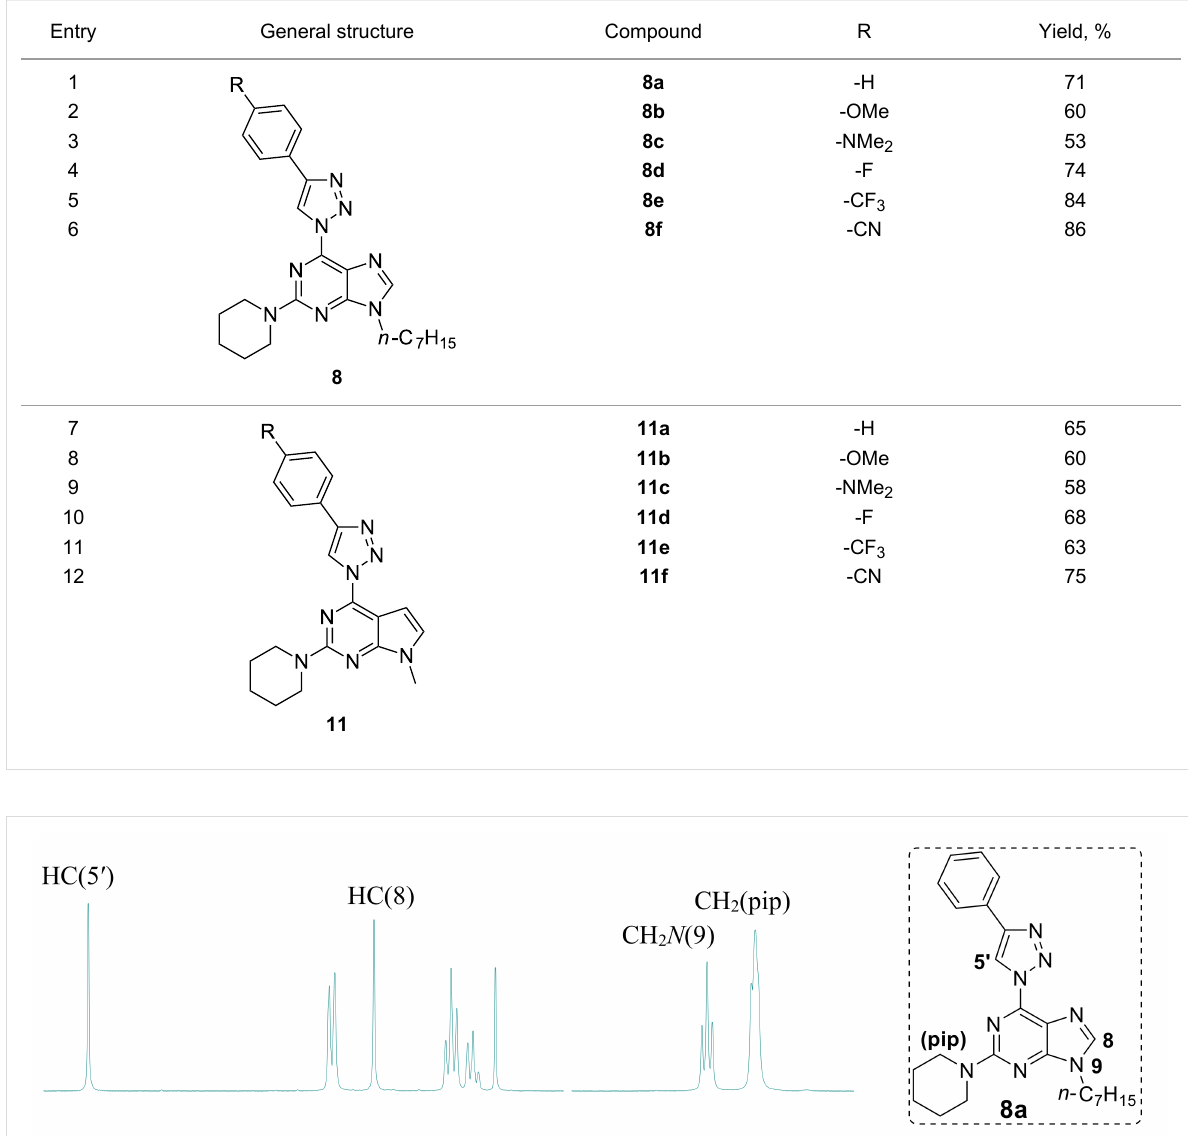
Table 2: Diversity of 9-alkyl-2-piperidino-6-triazolylpurine 8 and 7-deazapurine 11 derivatives obtained in reactions 6b → 8a–f and 3 → 11a–f according to Scheme 1.